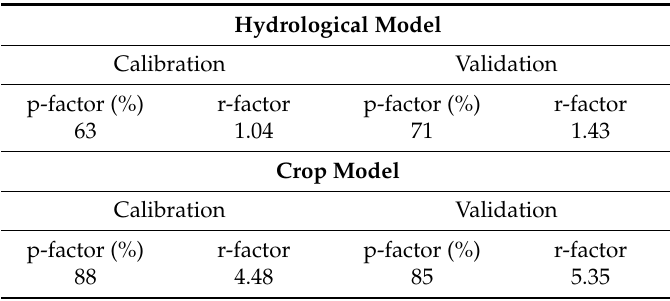
Table 2. Performance statistics for the SWAT hydrological and SWAT crop simulation models at the provincial